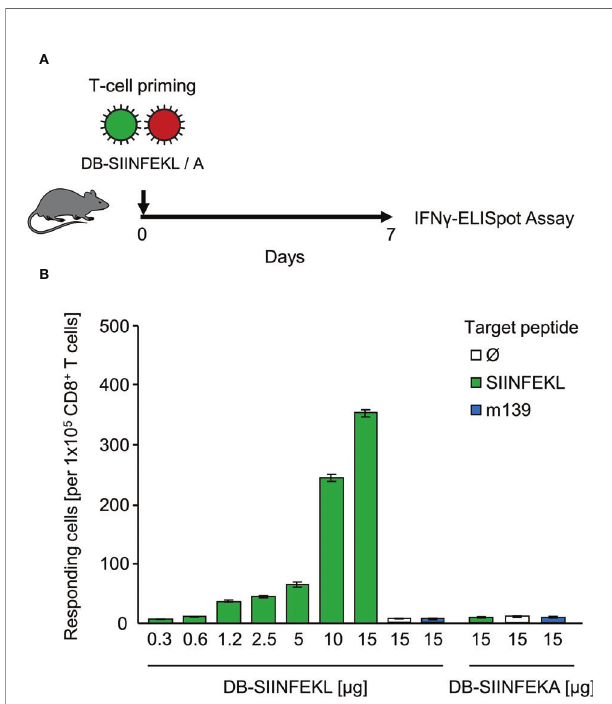
FIGURE 5 | Epitope-speci fi c priming of CD8 + T cells by recombinant dense bodies (DBs). (A) Experimental protocol. On day 7 after intraplantar application of graded m g-doses of DB-SIINFEKL or DB-SIINFEKA to immunocompetent C57BL/6 mice, frequencies of functional, viral epitope-speci fi c CD8 + T cells recovered from the spleen (from three mice pooled) were determined by an IFN g -ELISpot assay. (B) Frequencies of primed cells speci fi c for the viral epitopes indicated. For stimulation in the assay, EL-4 cells were exogenously loaded with the corresponding synthetic antigenic peptides at a saturating concentration of 10 -7 M. (Ø), no peptide loaded. Bars represent numbers of responding cells. Error bars indicate the 95% con fi dence